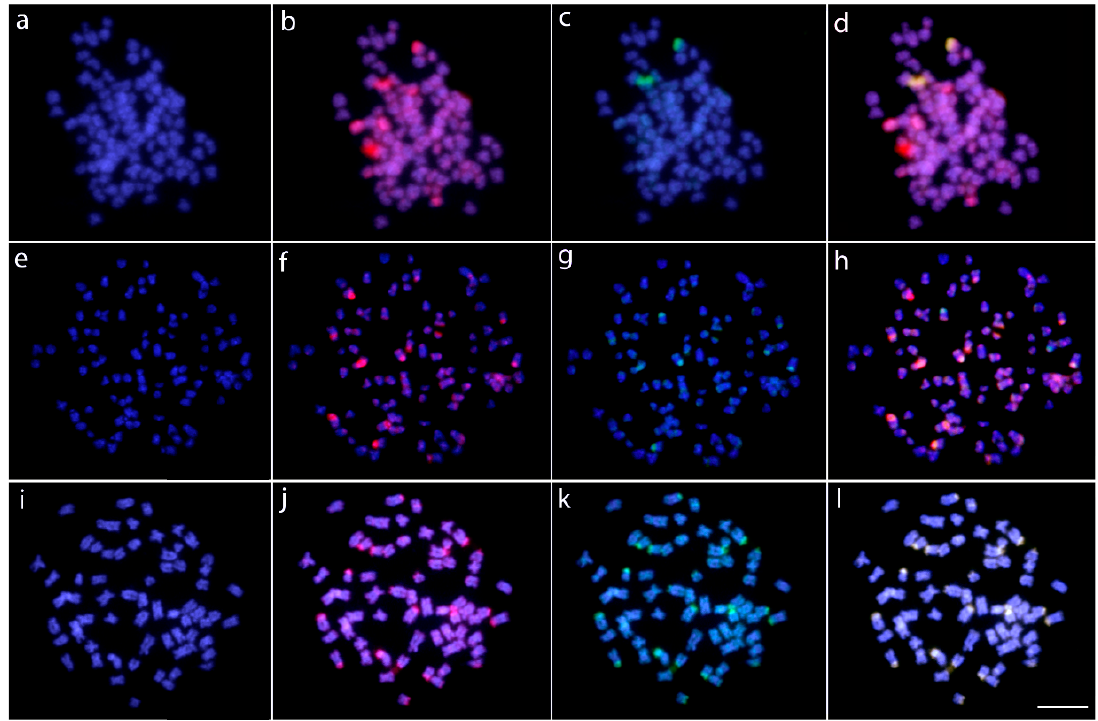
Figure 6. Metaphase chromosome spreads of Kryptopterus geminus ( a – d ), Wallago attu ( e – h ), and Phalacronotus bleekeri ( i – l ) after comparative genomic hybridization (CGH) procedures. Male-derived genomic probes from K. geminus and K. limpok were hybridized together against male chromosomes of K. geminus ( a – d ). Male-derived genomic probes from W. attu and W. micropogon were hybridized together against male chromosomes of W. attu ( e – h ). Male-derived genomic probes from P. bleekeri and P. apogon were hybridized together against male chromosomes of P. bleekeri ( i – l ). First column ( a , e , i ): DAPI images (blue). Second column ( b , f , j ): hybridization pattern using K. geminus ( b ), W. attu ( f ), and P. bleekeri ( j ) gDNA probes (red). Third column ( c , g , k ): hybridization pattern using K. limpok ( c ), W. micropogon ( g ), and P. apogon ( k ) gDNA probes (green). Fourth column ( d , h , l ): merged images of both genomic probes and DAPI staining. The shared genomic regions are depicted in yellow. Bar = 5 µm.